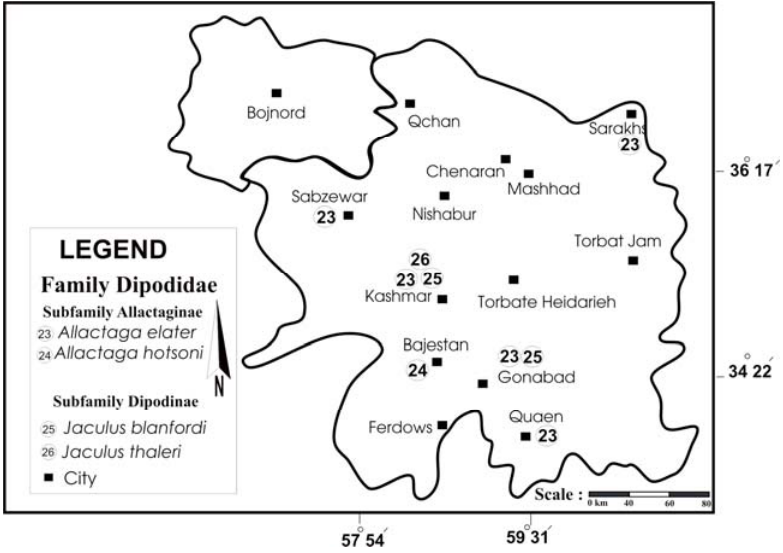
F IG . 6. - Map of northeastern Iran with collecting sites for different species of Family Dipodidae, indicated with numbers (the numbers are the same as in text and tables